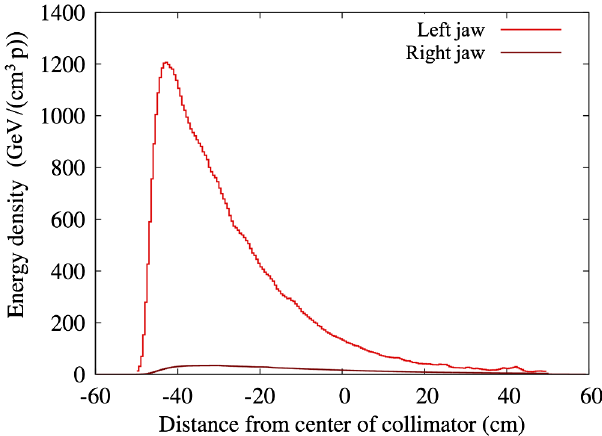
FIG. 13. Peak deposited energy profile along the TCTH.4L1.B1 jaws for Case 2.